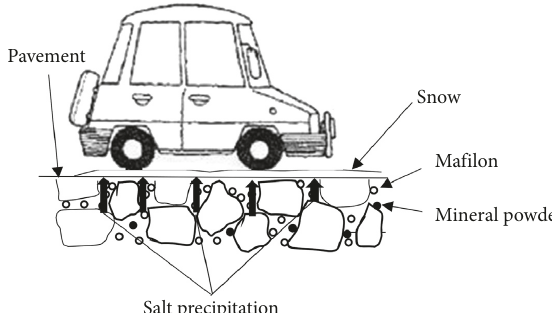
Figure 1: Schematic diagram of sustained-release snow melting asphalt